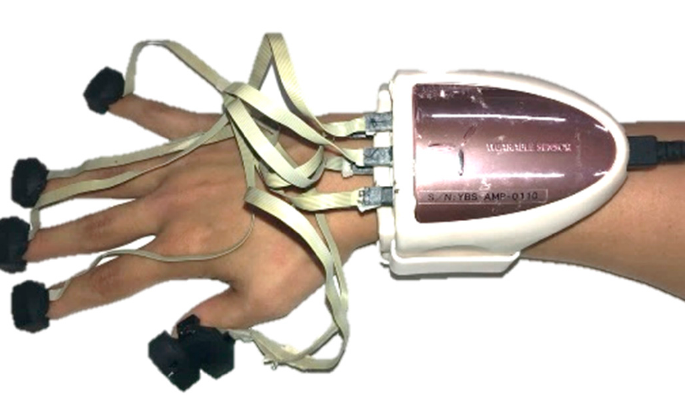
Figure 2. Mounting of sensors. Two HapLogs were used, and a sensor of each HapLog was attached to the thumb.